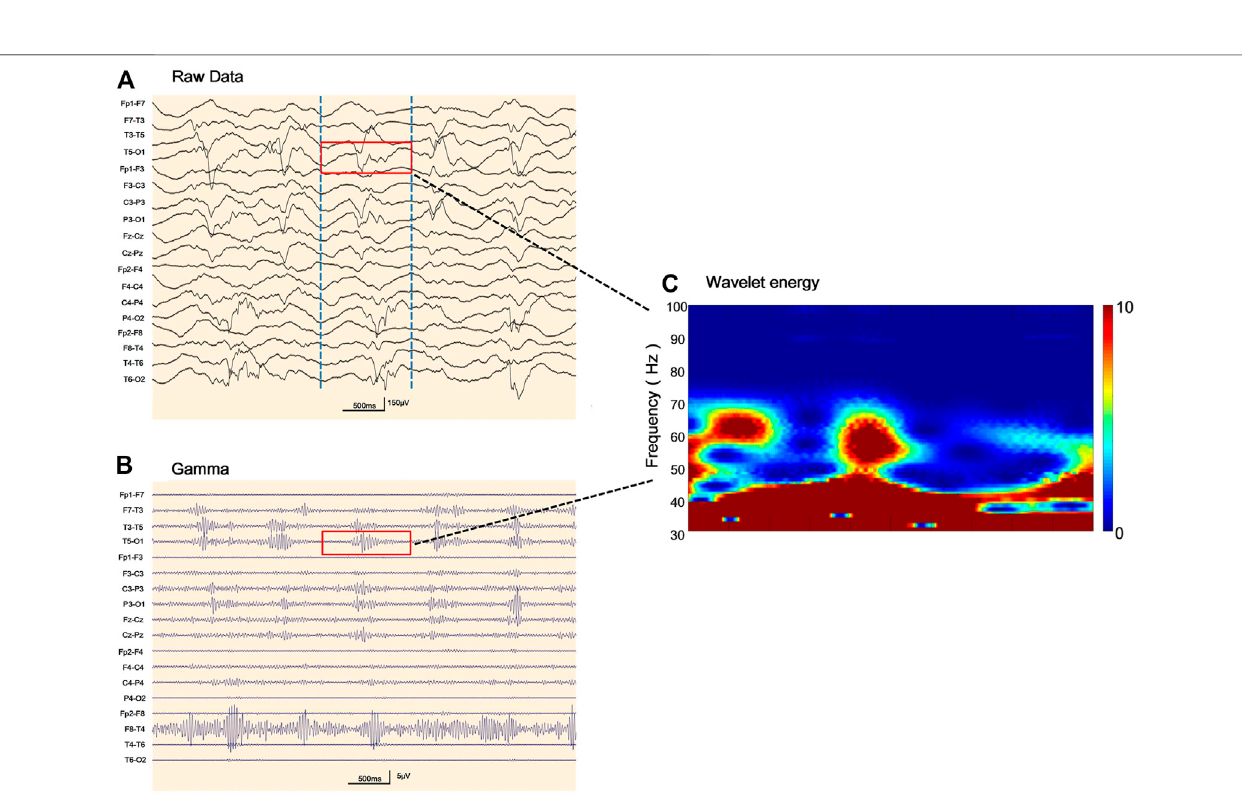
Frontiers in Pharmacology |